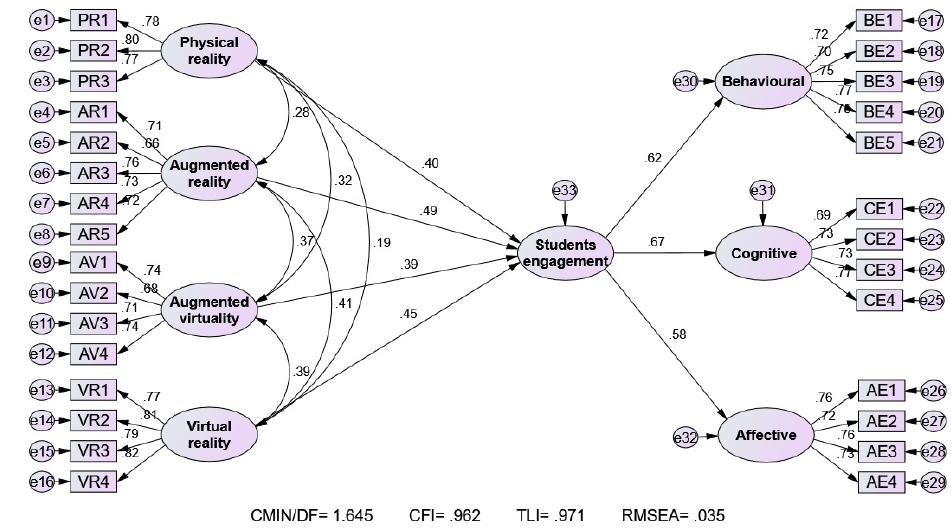
Fig. 3. SEM for the impact of mixed reality on students’ engagement